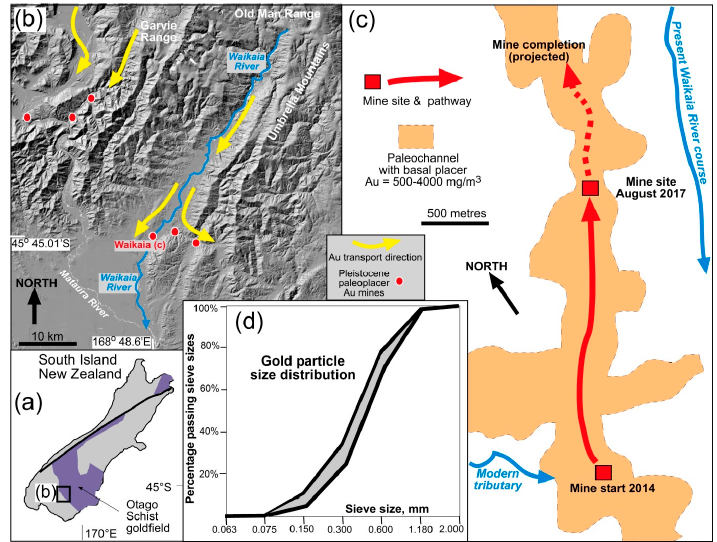
Figure 1. Location and deposit characteristics of the Waikaia placer gold mine, southern New Zealand, summarised from [23]. ( a ) Location of the mine on the southwestern margin of the Otago Schist goldfield; ( b ) Topographic setting of the mine in the Waikaia River valley, with placer gold transport directions; ( c ) Geometry of the late Pleistocene paleochannel in which the mine is located; ( d ) Typical gold particle size distributions in the basal gravels of the paleochannel, based on exploration data for the whole